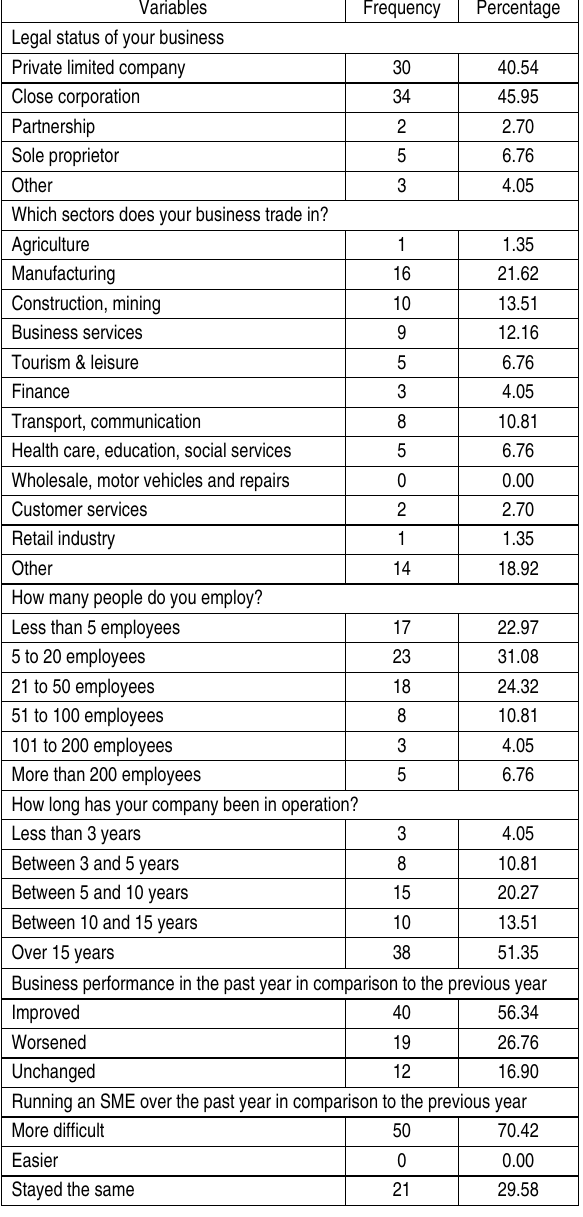
Table 3. Background information of the participated SMEs